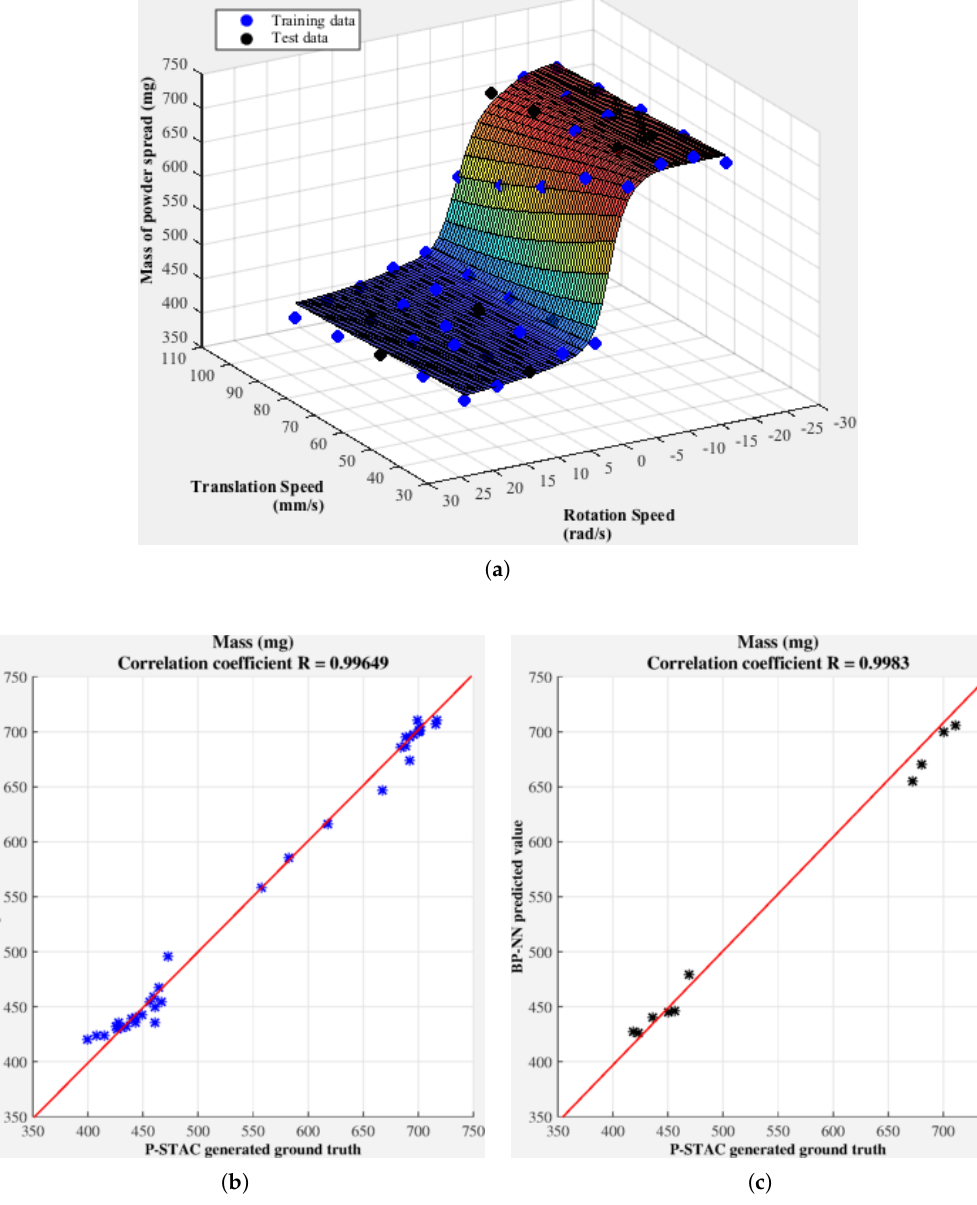
Figure 6. BP-NN predictions for the spreadability metric of mass of powder in the sampling region, M s for the case of spreading Ti-6Al-4V powder on an additively manufactured spreading substrate with S q = 79 µ m ( a ) Regressed surface ( b ) Training data ( c ) Test